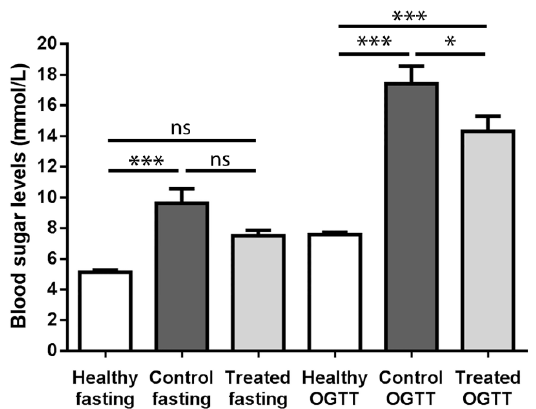
Figure 1. Blood sugar levels of animals before (fasting) and after oral glucose tolerance test (OGTT). Values are mean ± SEM in mmol/L. ns = no significant difference; * p < 0.05; *** p < 0.001.